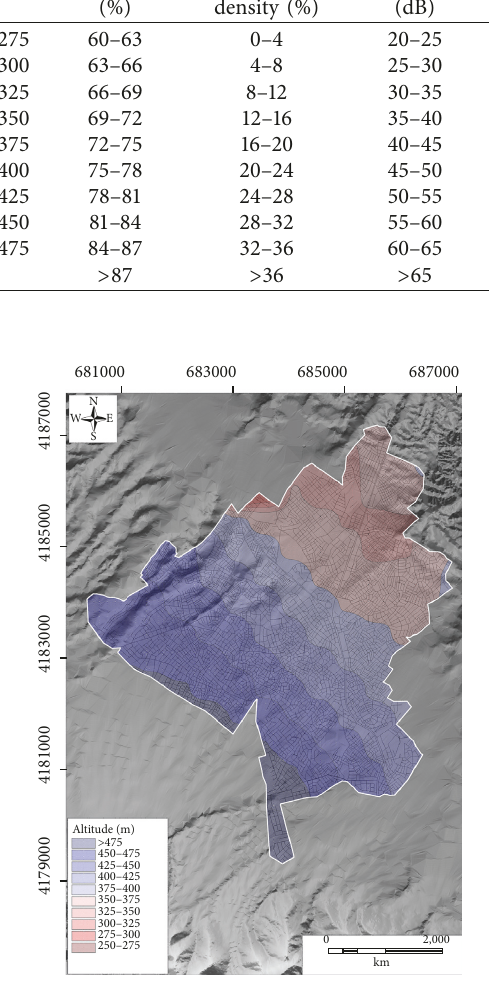
Figure 3: Altitude